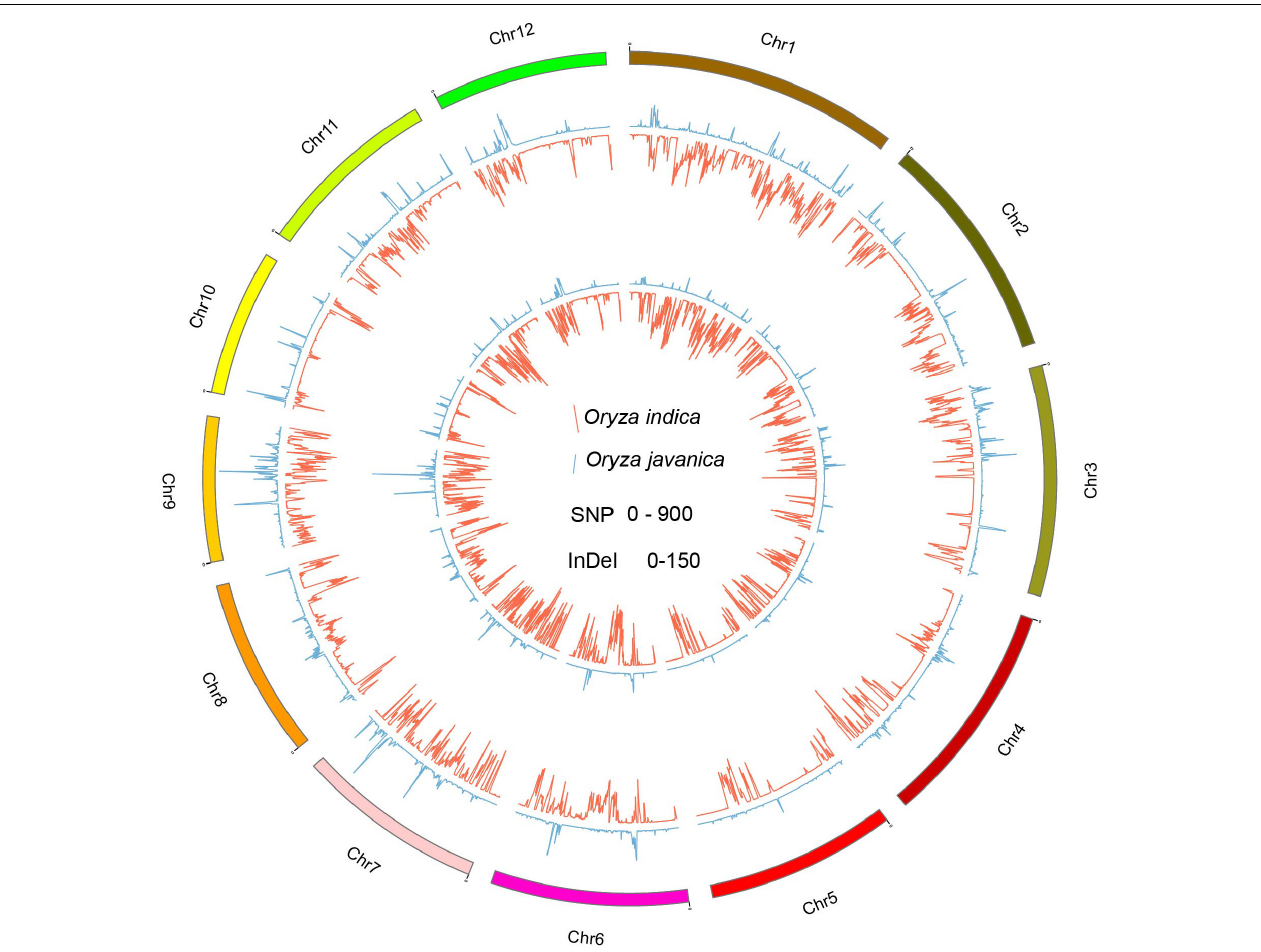
FIGURE 4 | The genome-wide distribution of private variation between the two subspecies. The inside Circos indicates the private SNP variation pattern among the whole genome. The outside Circos shows the private InDel variation number distribution along the whole genome. Red indicates indica, and green means